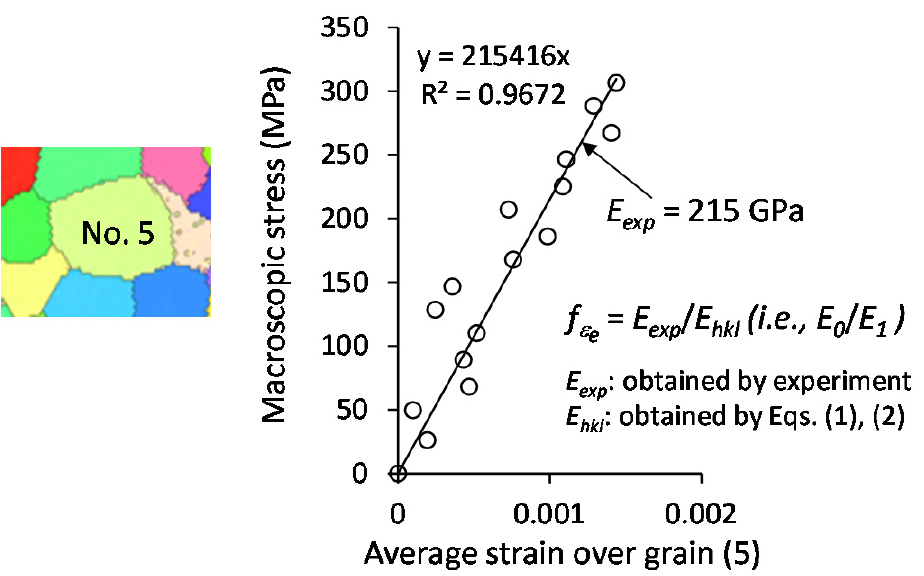
Figure 5. Determination of the Young’s modulus and elastic–strain ratio of grain (5) shown in Figure 3b. Table 1. Young’s modulus and elastic–strain ratio of individual grains.